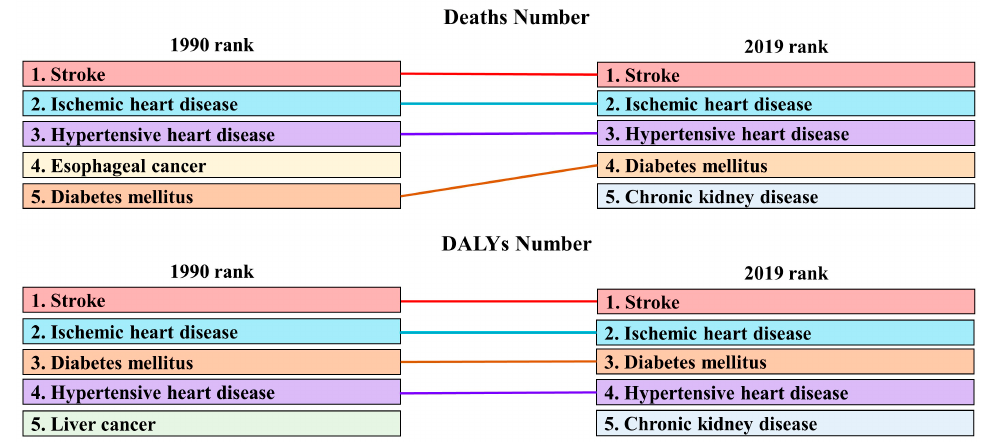
Figure 4. The top 5 high-BMI-related diseases by absolute number of deaths and DLAYs in 1990 and 2019.